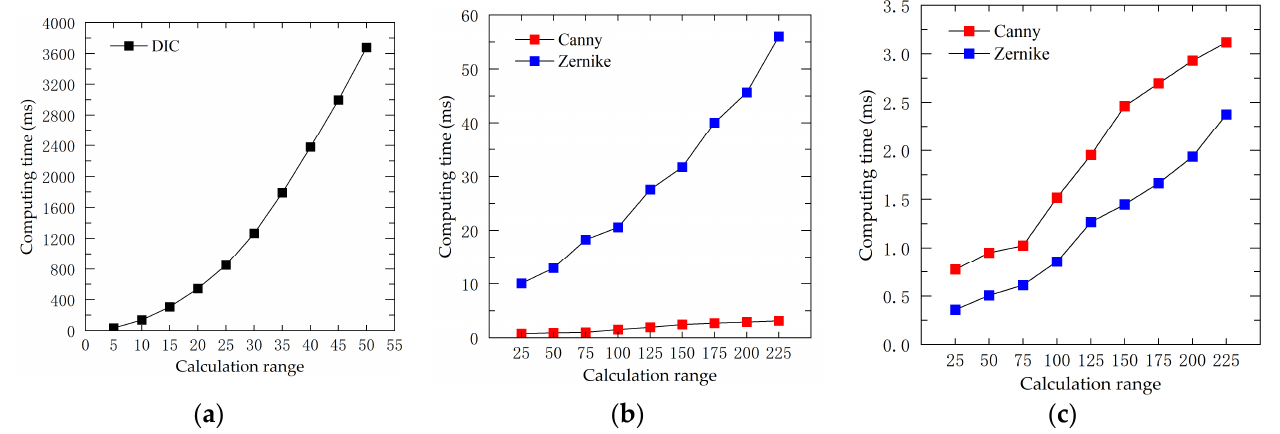
Figure 8. Algorithm speed comparison: ( a ) DIC algorithm; ( b ) DIP before CUDA acceleration; and ( c ) DIP after CUDA acceleration.